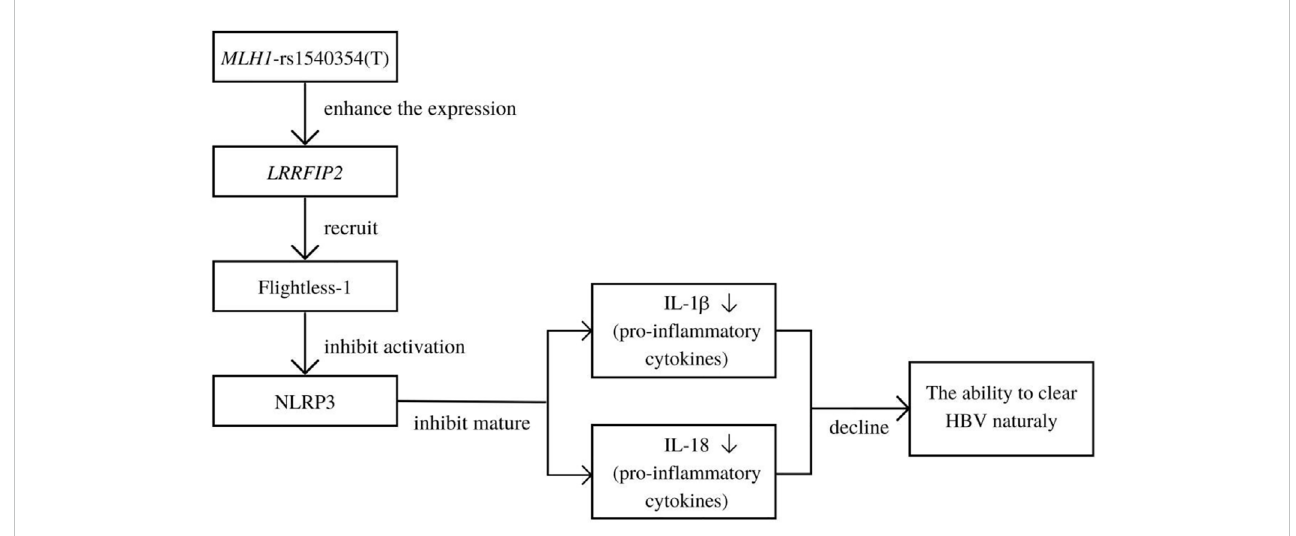
FIGURE 2 Mechanism of MLH1 -rs1540354(T) mutant affecting human ability to spontaneously clear